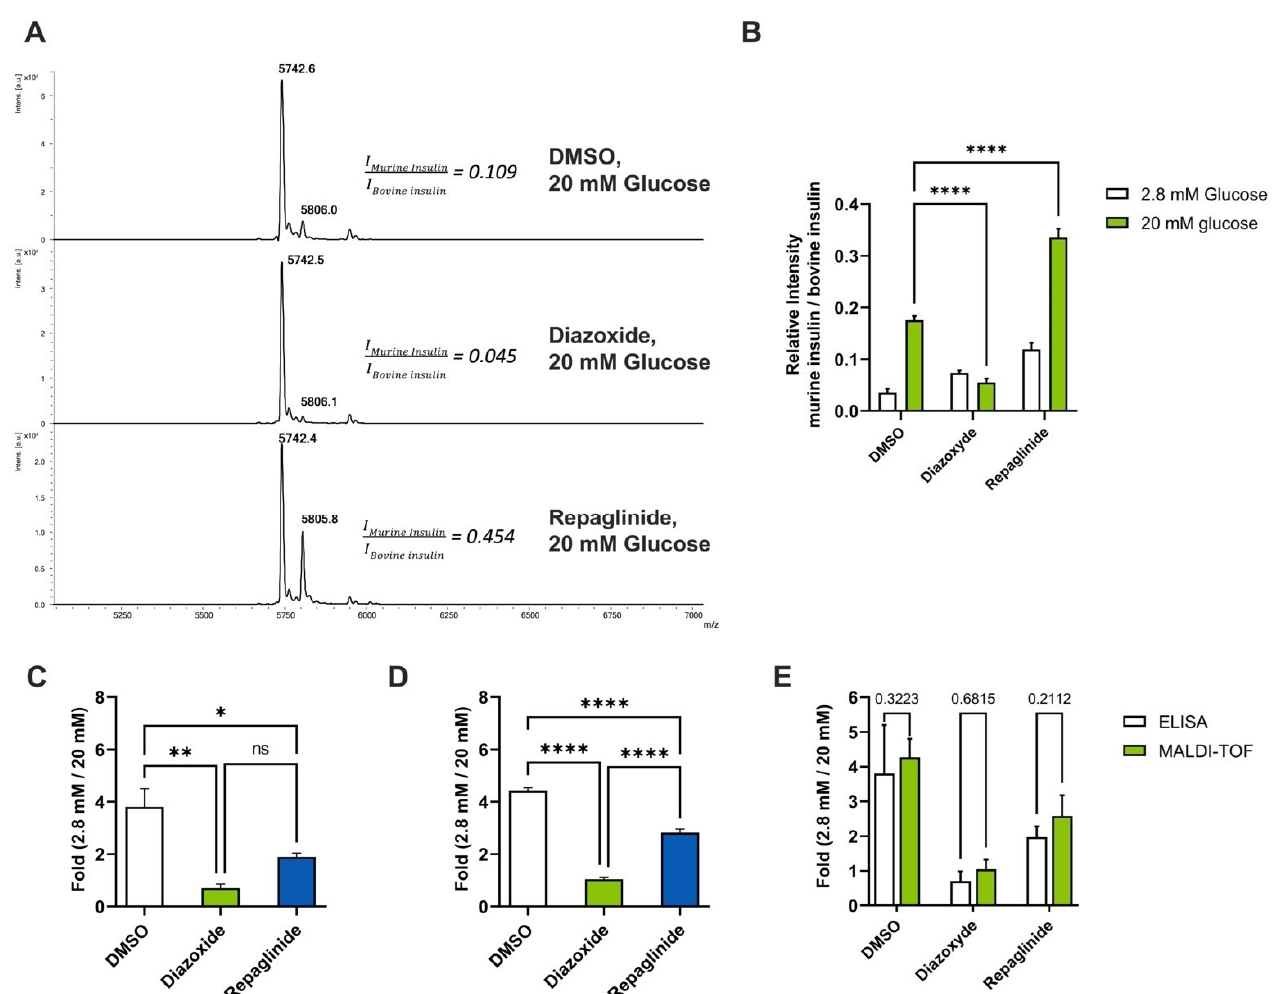
Figure 4. Min6 insulin secretion analysis of Min6 cells treated with diazoxide and repaglinide by MALDI-TOF mass spectrometry. ( A ) Mass spectra of the 20 mM secretomes of Min6 cells treated with DMSO, diazoxide 100 µ M and repaglinide 100 nM; Quantification of insulin secretion after stimulation with glucose 2.8 mM and 20 mM of Min6 cells treated with DMSO, diazoxide 100 µ M and repaglinide 100 nM ( B , D ) by MALDI-TOF mass spectrometry and ( C ) by ELISA. ( E ) Comparison of results obtained by mass spectrometry and ELISA assay. Two-way ANOVA with Bonferroni post-test analyses. Error bars are ± SEM and n = 4 for ELISA, n = 32 for MS. * p < 0.05; ** p < 0.01; **** p <